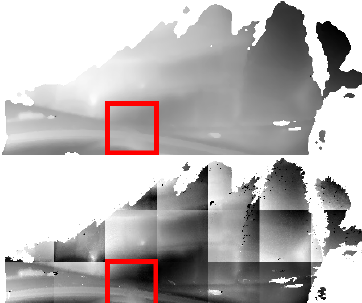
Figure 5: Top: Globally normalized photo heightfield, Bottom: Locally normalized photo heightfield. The red square indicates the same region in both